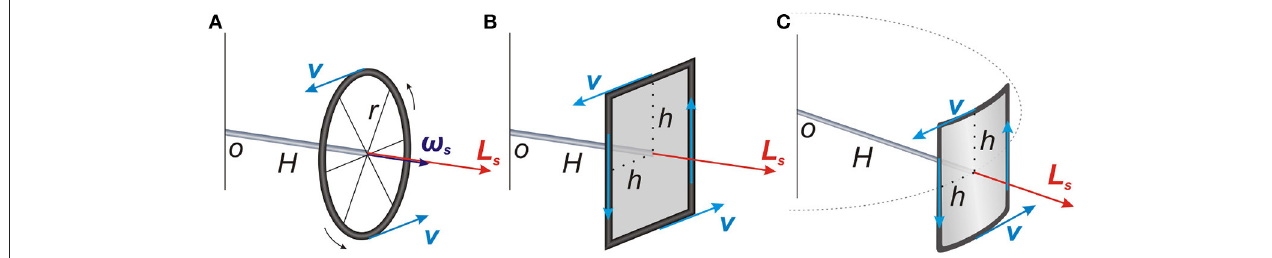
FIGURE 2 | (color online) Simple models of a heavy top. v represent the flow velocities relative to the center of mass. (A) Spinning wheel with an angular momentum L s = mr 2 ω s where v = r ω s (B) Square wheel with an angular momentum L s = mvh generated by a heavy, ideal fluid flowing, or an ideally flexible, frictionless chain running in a square-shaped hoop. This model allows the straightforward analytic treatment of the problem in inertial and precessing reference frames. (C) Bent square wheel model of a heavy top providing circular trajectories for the chain or fluid particles in the upper and lower segments of the hoop. This approach allows a simple intuitive understanding of the precession in inertial and body (connected to the fluid/chain) reference